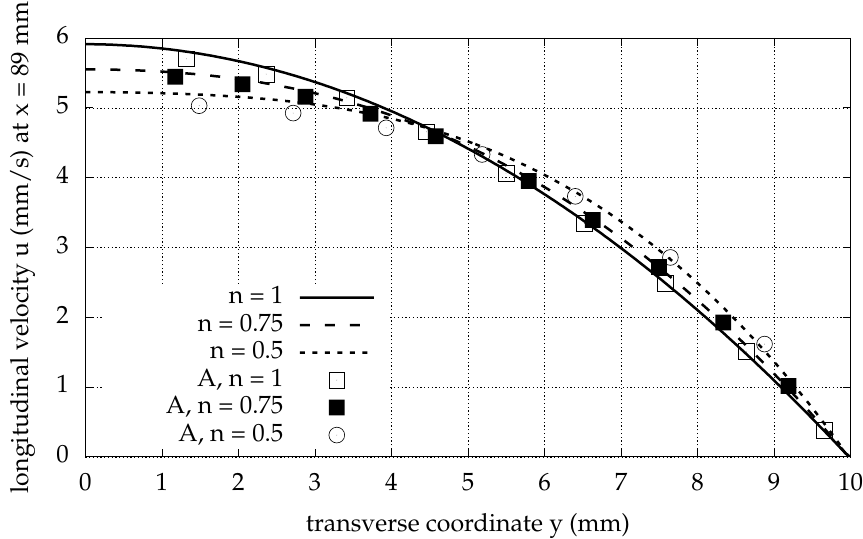
Figure 7. Longitudinal velocity profile at x = 89 mm for Newtonian and non-Newtonian fluids. The roller speed is c = 5 mm/s, the relative occlusion is RO = 0.6 and there is one roller. Comparison with existing results (A: Data from [12]) is presented.